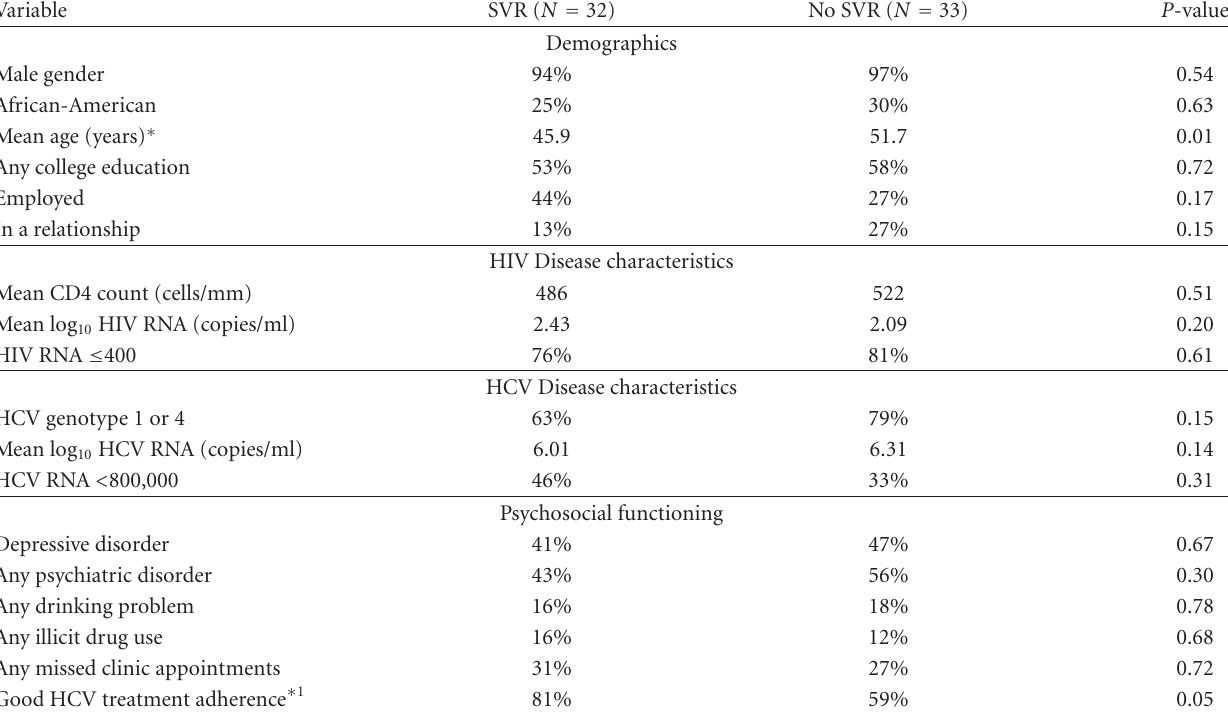
Table 3: Patient characteristics and sustained virologic response (SVR) to HCV